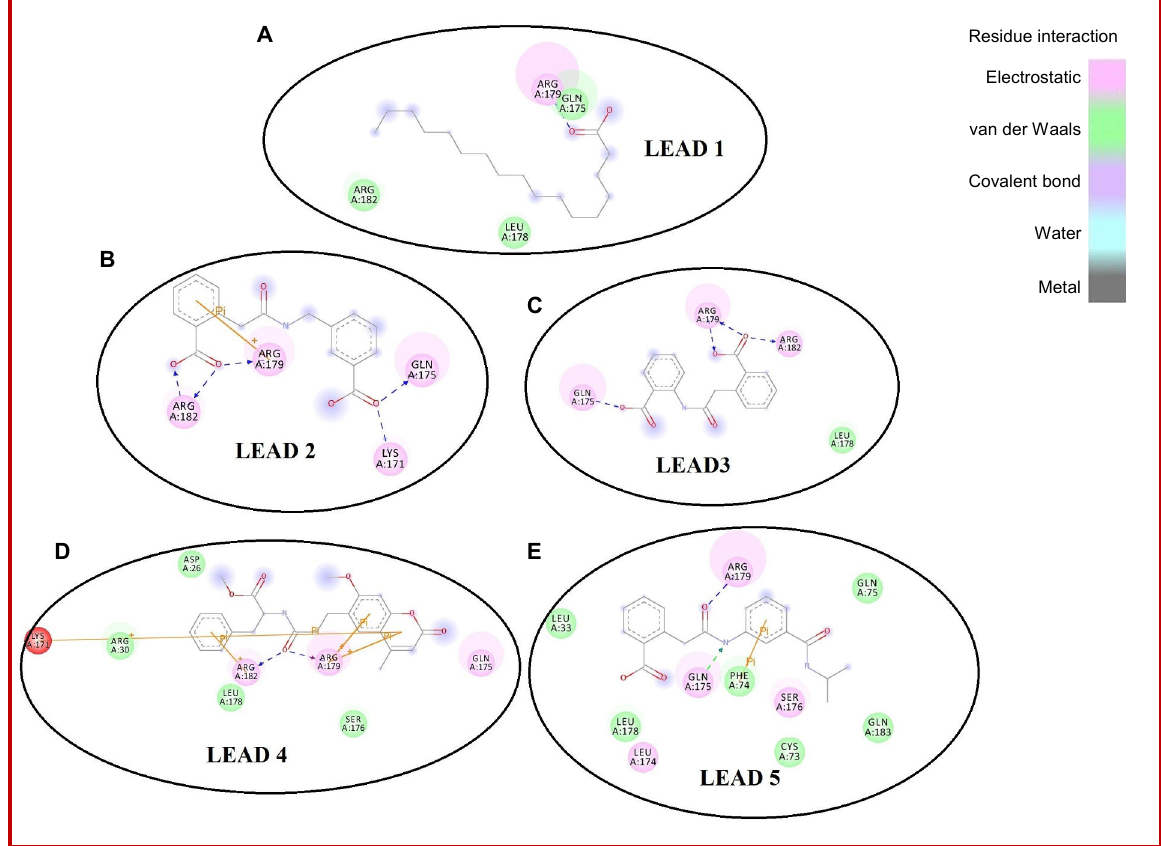
Figure 4: 3D mapping of lead compounds with their respective hits where (A, B, C and E) represent the lead compounds in order